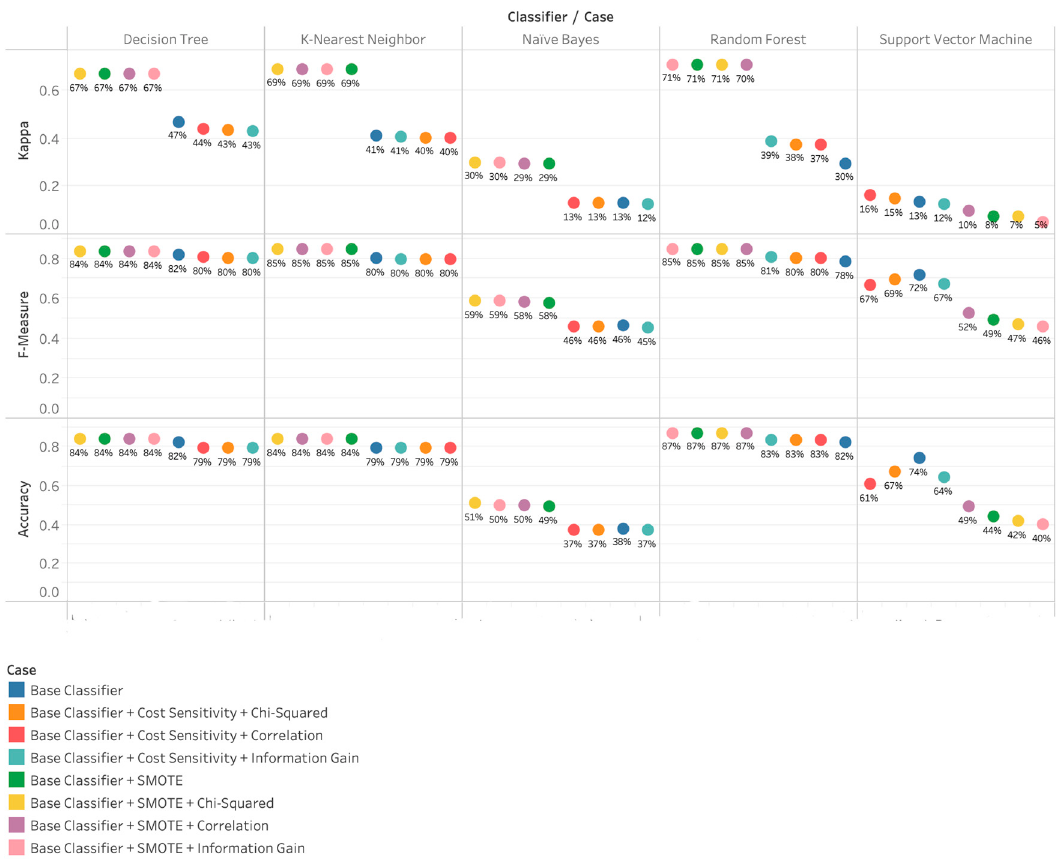
Figure 4. Results achieved with Word to Vector (baseline 2).